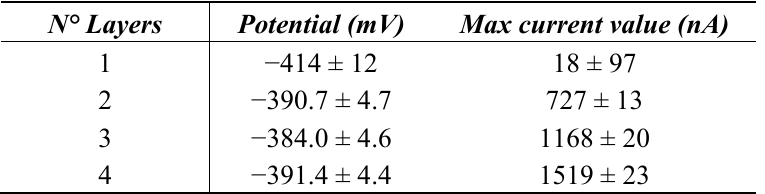
Table 1. Current peaks and the related potential positions obtained with cyclic voltammetry in PBS for different number of CYP3A4